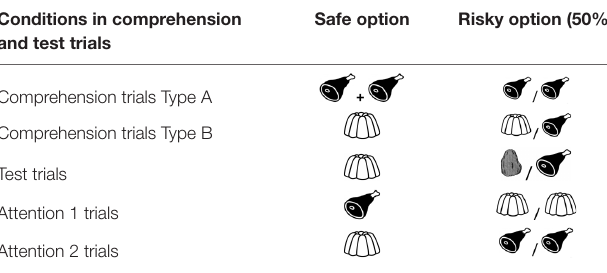
TABLE 1 | Food distribution in the safe and risky option in comprehension and test